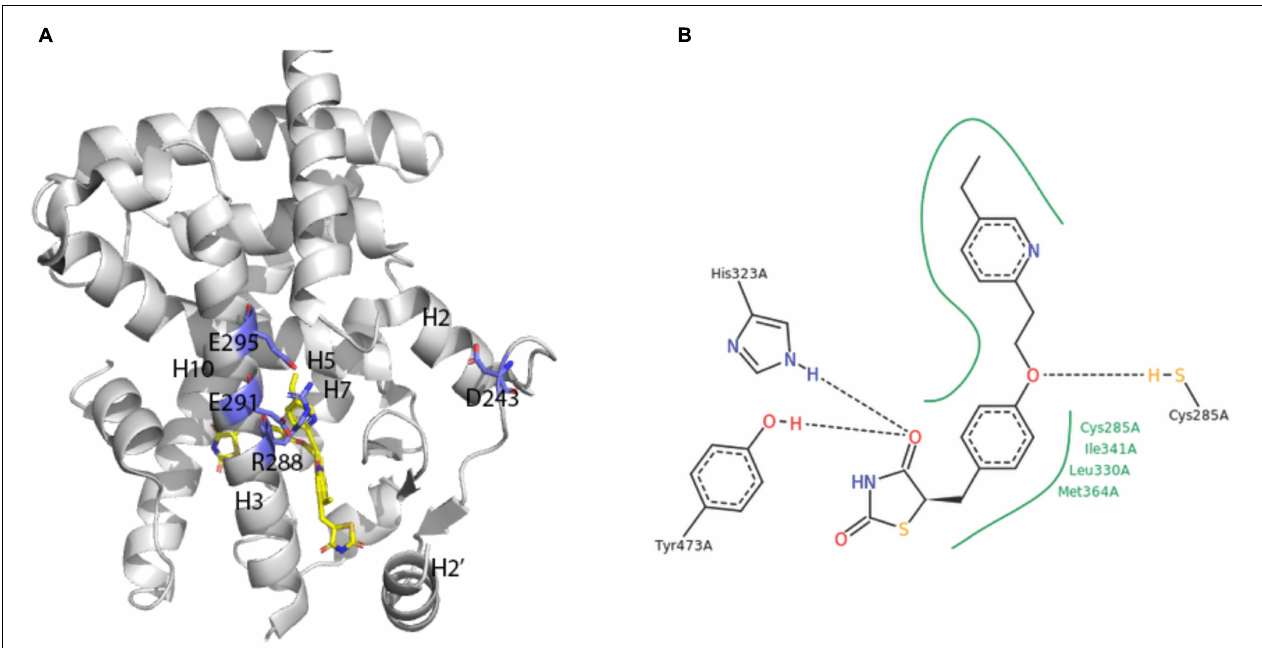
FIGURE 4 | X-ray crystal structure of PPAR γ ligand binding domain (A) The apo-human PPAR γ recombinant protein structure (1PRG deposited by Nolte et al., 1998) was obtained from the RCSB protein database (Berman et al., 2000). Key placements of helix 3 (H3), as well as key hydrophilic and hydrophobic residues at the surface of the entry to the ligand-binding site are indicated. (B) Structure of pioglitazone detailing interaction sites with the ligand binding domain of human PPAR γ (Structure 2XKW from RCSB, Mueller et al.,